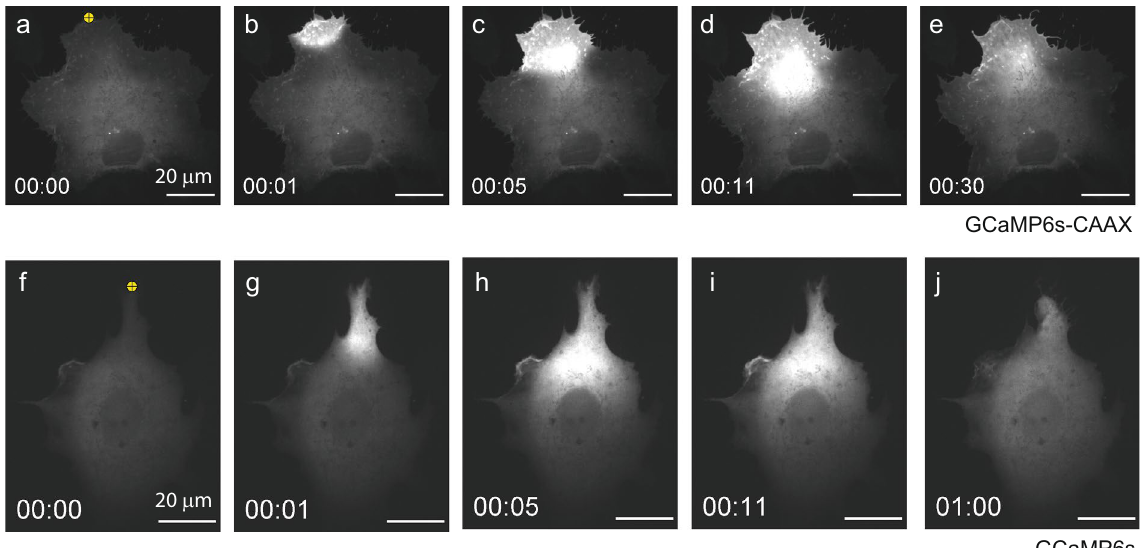
Figure 2. Time-lapse fluorescence data for the cytosolic calcium distribution in an MCF7 breast carcinoma cell during UV-laser induced plasma membrane damage and repair. Sequence in ( a – e ) was acquired with the membrane bound probe GCaMP6s-CAAX while sequence in ( f – j ) was acquired with the cytoplasma probe GCaMP6s. Laser damage to the plasma membrane was induced at the marked point (yellow) in the cell at time t = 0 s. All images within one sequence are displayed at the same intensity